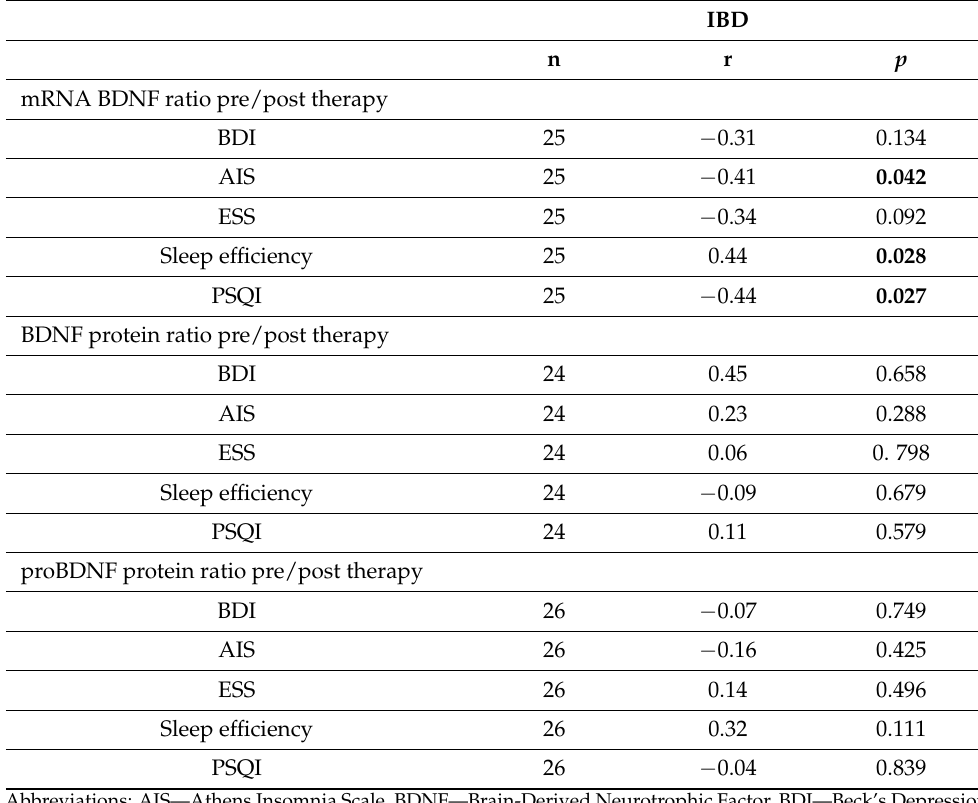
Table 6. Correlations between changes in neurotrophin expressions post anti-TNF therapy, question- naire scores, and sleep efficiency.